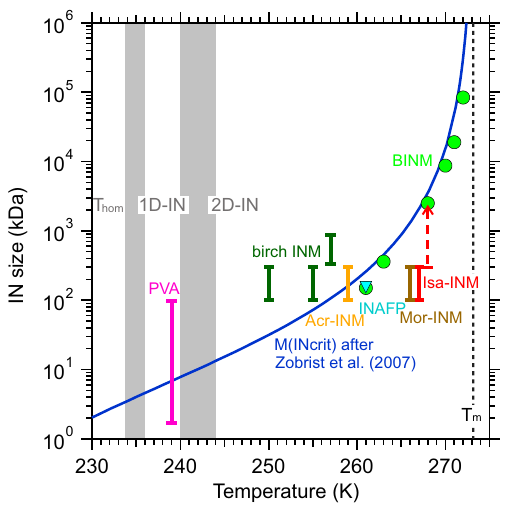
Figure 4. The dependence of the median freezing temperature on size for different types of IN (colored dots). The blue curve is the calculated critical ice cluster size derived from classical nucleation theory (Zobrist et al., 2007). The sources of the presented IN data are listed in Table 3. The graph further shows the region where we assume the domains where 1-D and 2-D templates act as IN. The grey areas mark the transition regions between the domains. The acronyms Acr , Isa , and Mor stand for the respective fungal